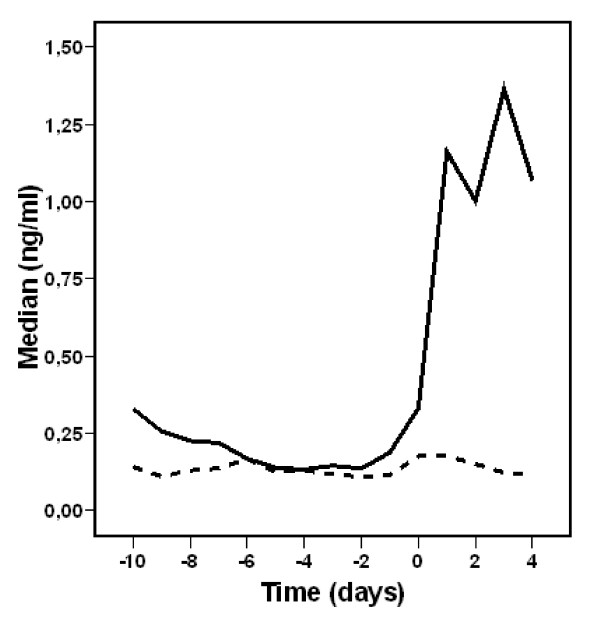
PCT values for patients with (constant line) and without (dotted line) proven infection before and after the onset of fever (D1). PCT: Procalcitonin, D1: Day1 (day of fever onset).